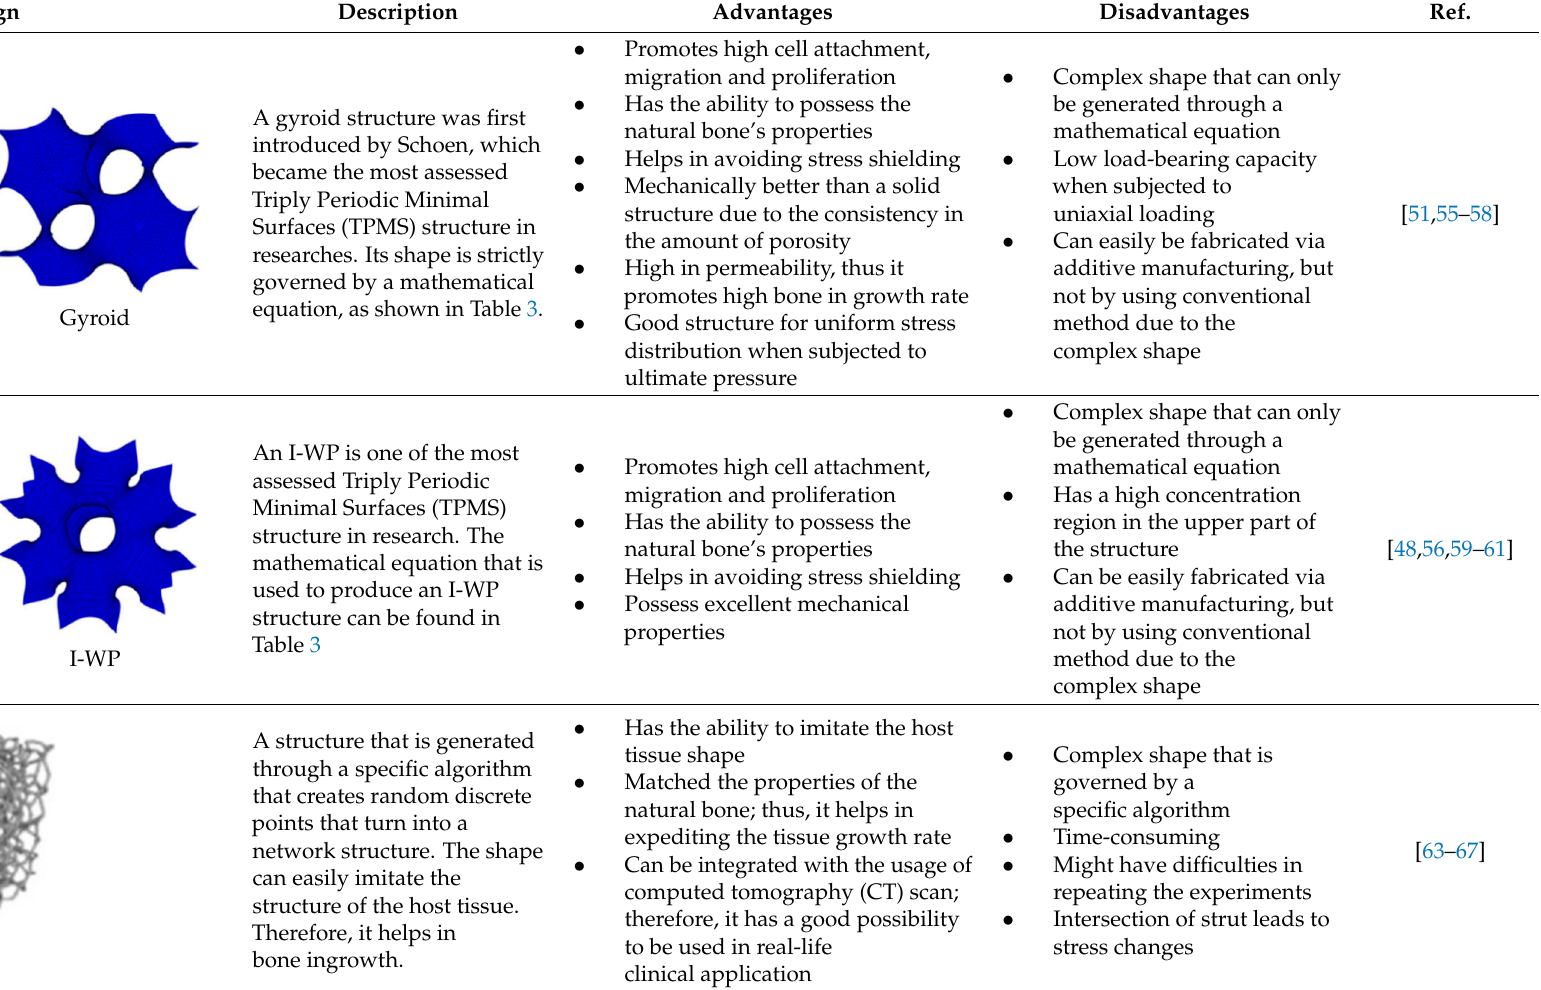
Table 2. Cont. Parametric Design Description Advantages